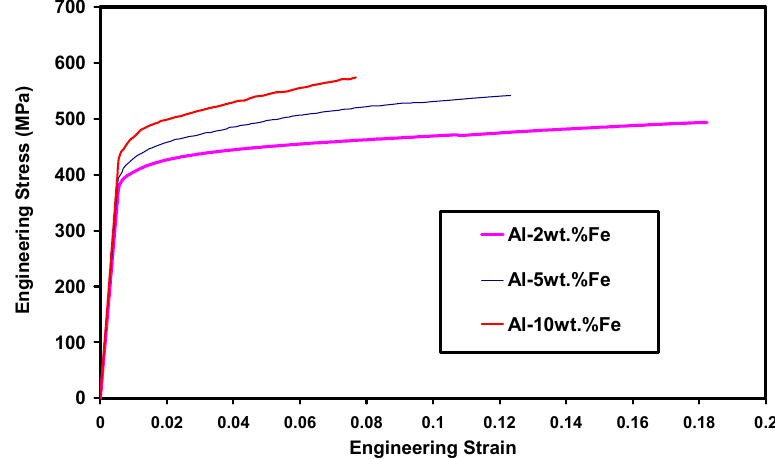
Figure 4. Compressive stress–strain response of Al-Fe fabricated alloys.